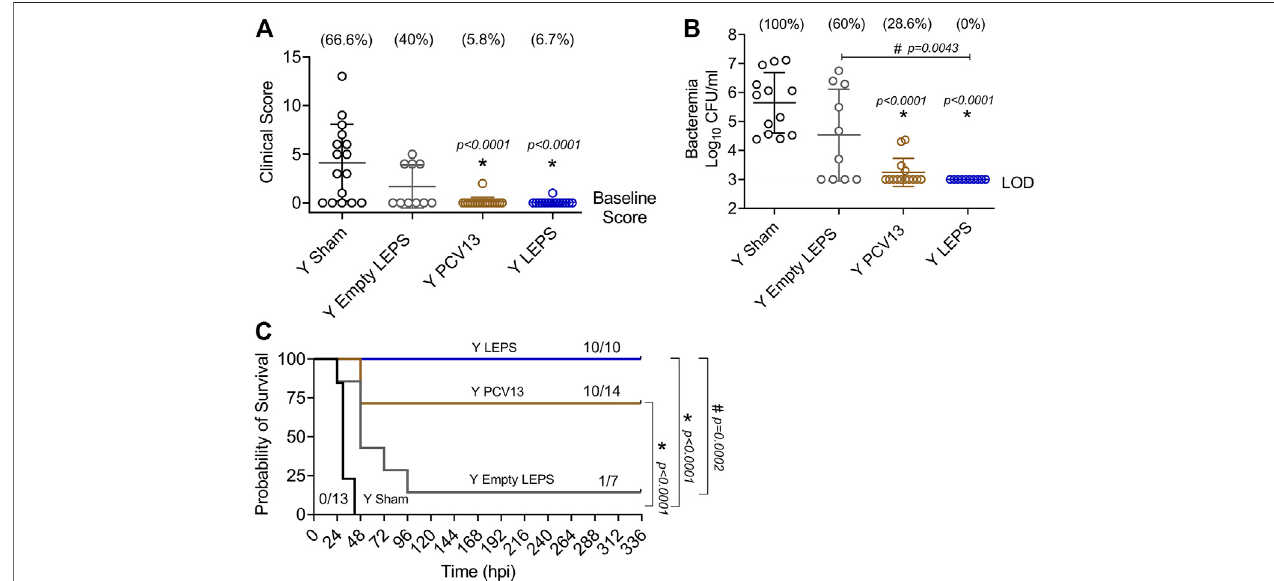
FIGURE 6 | LEPS vaccination confers similar protection to Prevnar13 in young mice against invasive pneumococcal infection. Young (2 – 3 months) C57BL/6 mice were immunized with LEPS containing serotype 4 capsular polysaccharide antigen, PCV13, or the controls (Sham or Empty LEPS vector). Four weeks later (timeline presented in Figure 1B ), mice were infected i.t. with 5 × 10 5 CFU of S. pneumoniae TIGR4 strain. Clinical scores (A) and bacterial numbers in the blood along with the incidence of bacteremia (% noted above each group) (B) were determined 24 h post-infection. Survival was also followed over time (C) . (A,B) Asterisks (*) indicate signi fi cantdifferenceswithrespecttotheShamgroup,andhashsigns(#)indicatesigni fi cantdifferencesbetweentheindicatedgroupsascalculatedbyone-wayANOVA followed by Tukey ’ s test. Pooled data are presented as mean ± SD and each dot represents one mouse. (C) Asterisks (*) indicate signi fi cant differences with respect to the Sham group, and hash signs (#) indicate signi fi cant differences between the indicated groups as determined by the log-rank (Mantel-Cox) test. Fractions denote surviving mice. Pooled data from two separate experiments with n (cid:2) 13 mice in the Sham group, n (cid:2) 7 mice in the Empty LEPS group, n (cid:2) 14 mice in the PCV13 group, and n (cid:2) 10 mice in the LEPS group are shown. LOD: limit of detection.